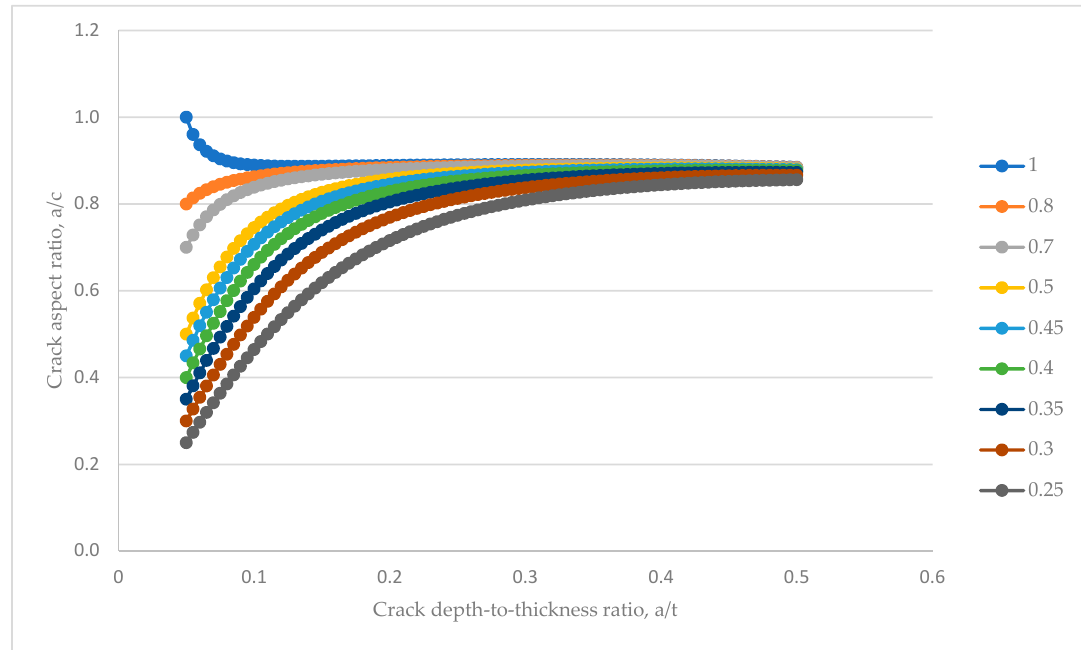
Figure 29. Change in aspect ratio with relative crack depths for internal surface cracks in a pipe under tension showing the final aspect ratio convergence. The legend indicates the initial crack aspect ratio values.